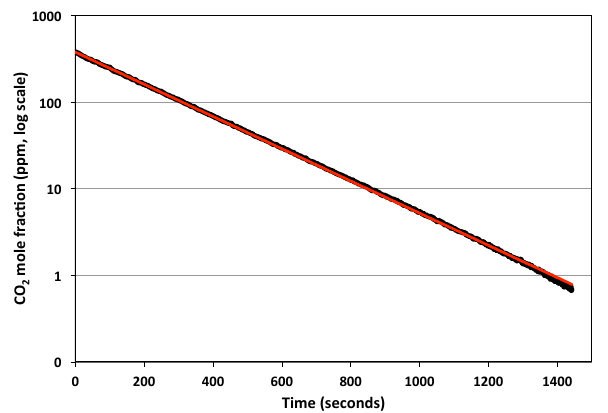
Fig. 2. Measured CO 2 mole fraction through time, starting with “ambient” 378.95ppm CO 2 air inside integrating volume. Air en- tering the volume was switched to “zero” 0ppm CO 2 air at time zero. Flow rate was set at 3.8SLPM.